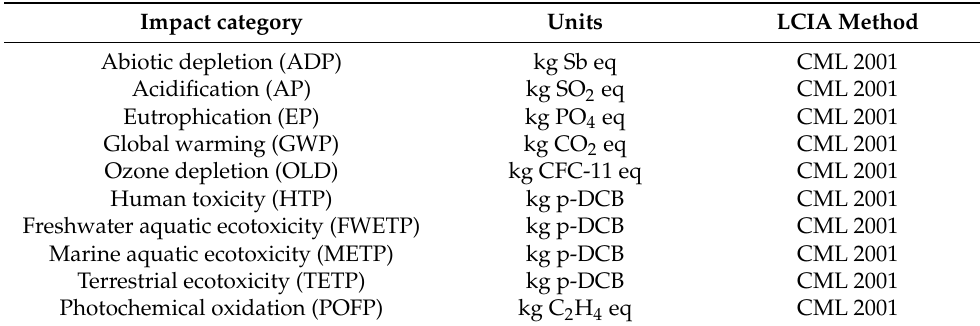
Table 6. Impact categories and method of